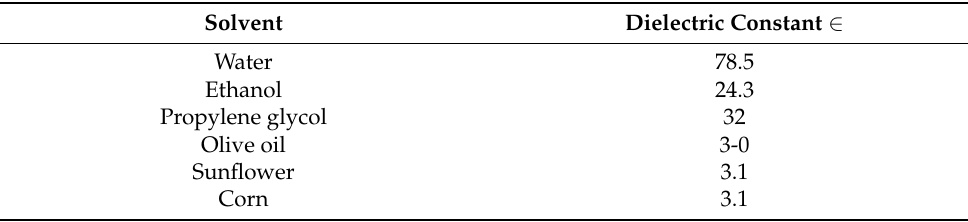
Table 3. The dielectric constants of some common solvents and cosolvents